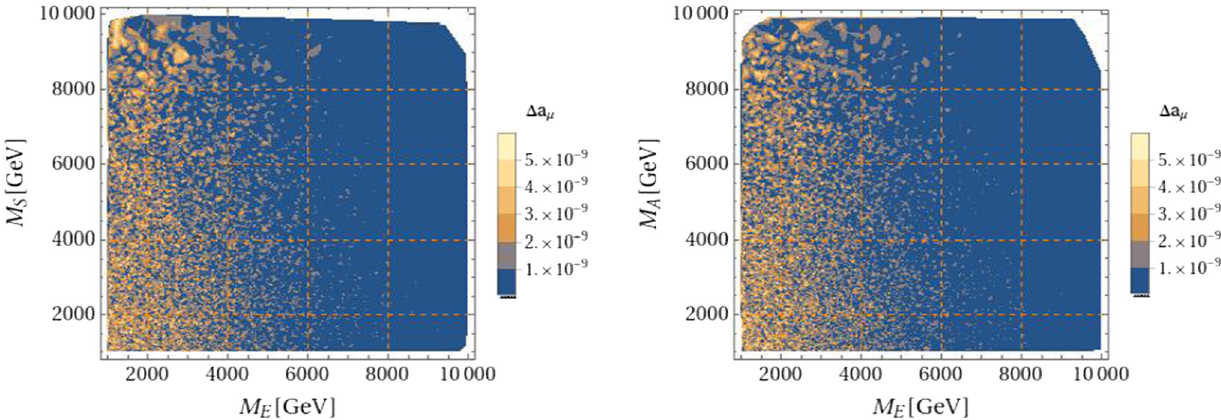
Fig. 5 Allowed parameter space for M S – M E (left panel) and M A – M E (right panel) planes with different values of the muon anomalous magnetic